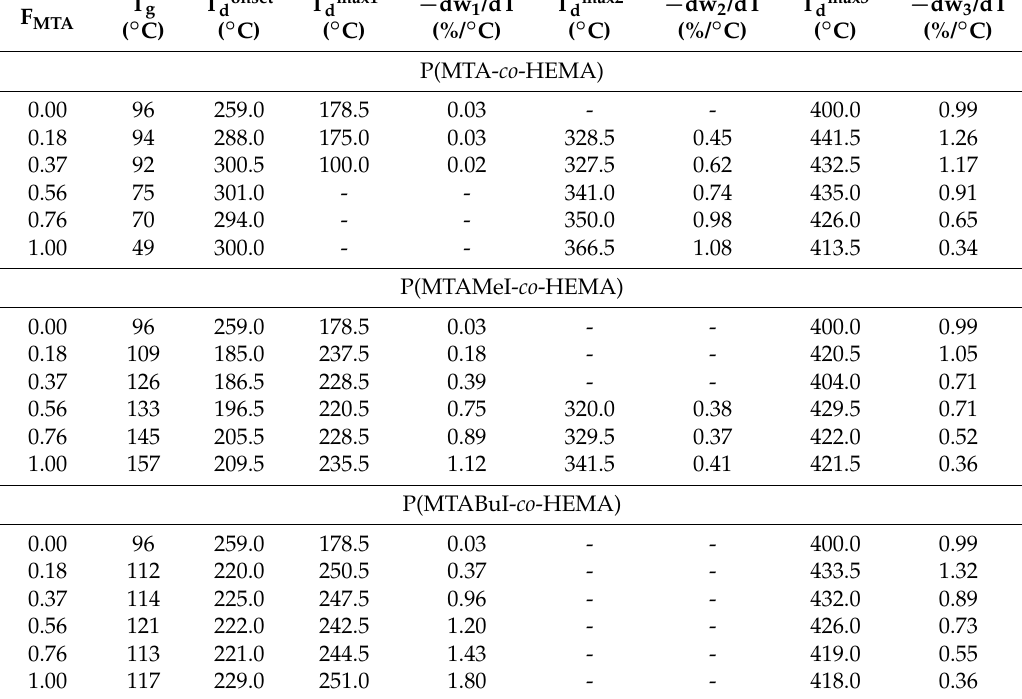
Table 2. Thermal characteristic parameters determined by DSC and TGA of the synthesized copolymers. Glass transition temperature, T g ; initial degradation temperature, T donset ; temperature of the maximum rate of weight loss for each step, T dmax ; and the rate of weight loss for each step, −